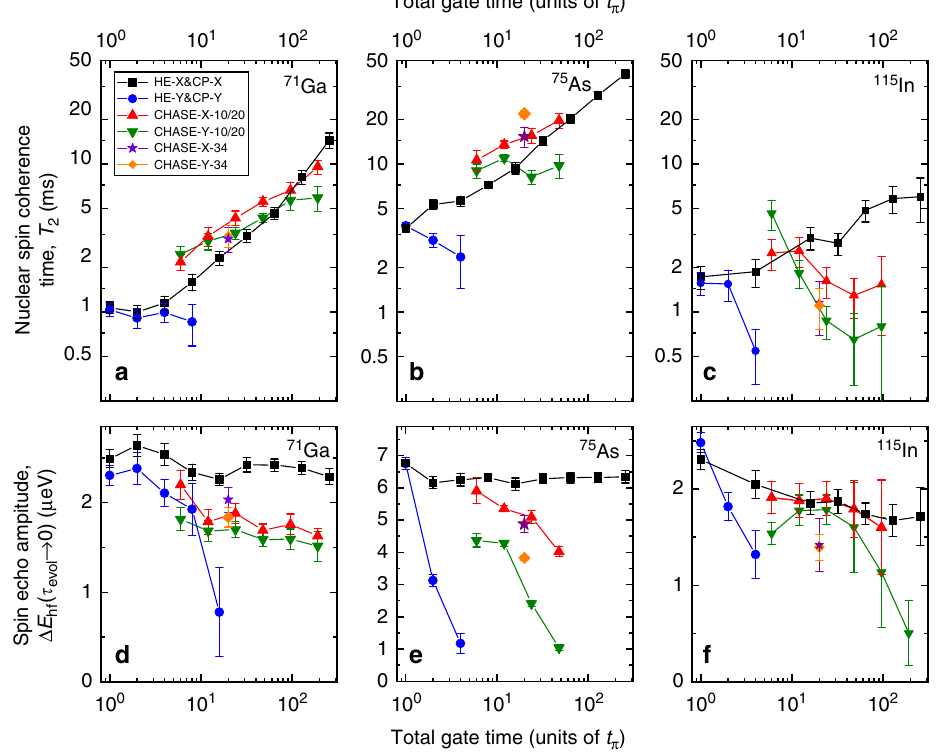
Fig. 3 Experimental nuclear spin decoherence in an InGaAs quantum dot. a – c Dependence of the fi tted 71 Ga ( a ), 75 As ( b ) and 115 In ( c ) spin coherence time T 2 on the number of sequence cycles n expressed as total rf gate time (in units of t π ). Results are shown for Hahn echo, CP and CHASE pulse sequences. d – f Respective fi tted spin echo amplitude Δ E hf ( τ evol → 0) at short free evolution time τ evol → 0 as a function of the total gate time. Error bars mark 90% con fi dence intervals. The data for one cycle of Hahn echo (HE) and CHASE-10 are combined with the data for integer cycle numbers n of CP and CHASE-20, respectively. The π -pulse durations used in these experiments are t π = 4.3 μ s ( 71 Ga), t π = 5.7 μ s ( 75 As) and t π = 4.7 μ s ( 115